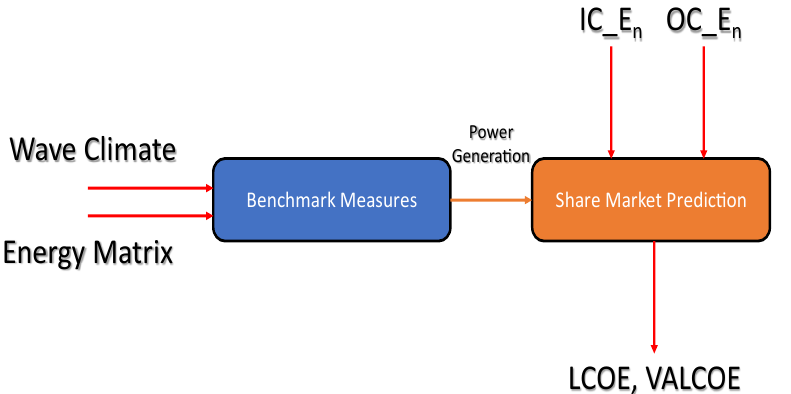
Figure 1. The LCOE vs. VALCOE contributions of energy conversion level.